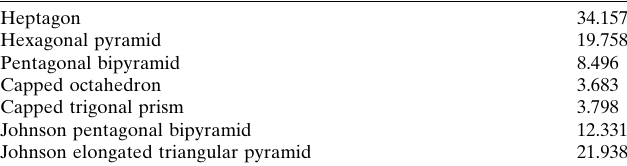
Table 2 Continuous shape measurement (CShM) values ( SHAPE 2.1 ) for the seven-coordinate sodium ion of 1